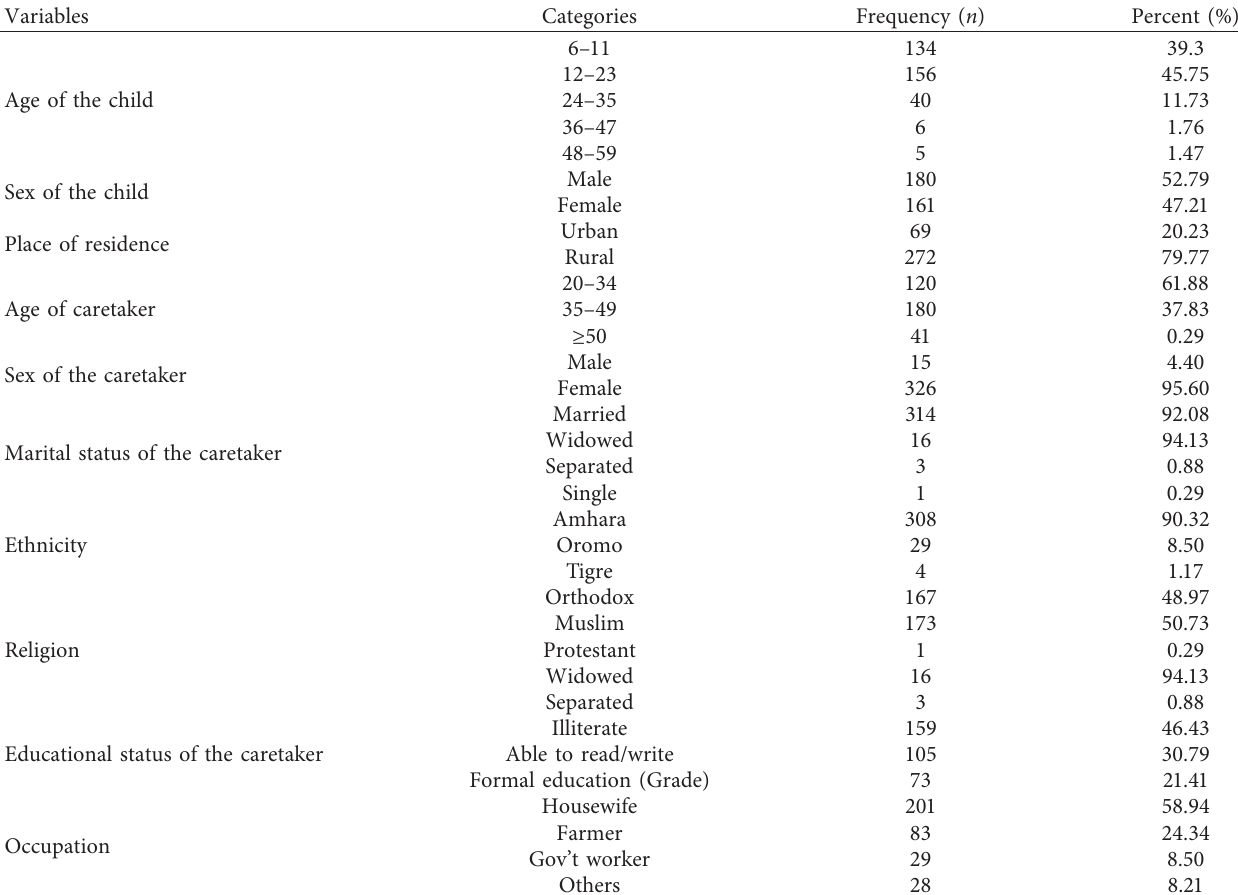
Table 1: Sociodemographic status of the study participants in East Amhara, Ethiopia,